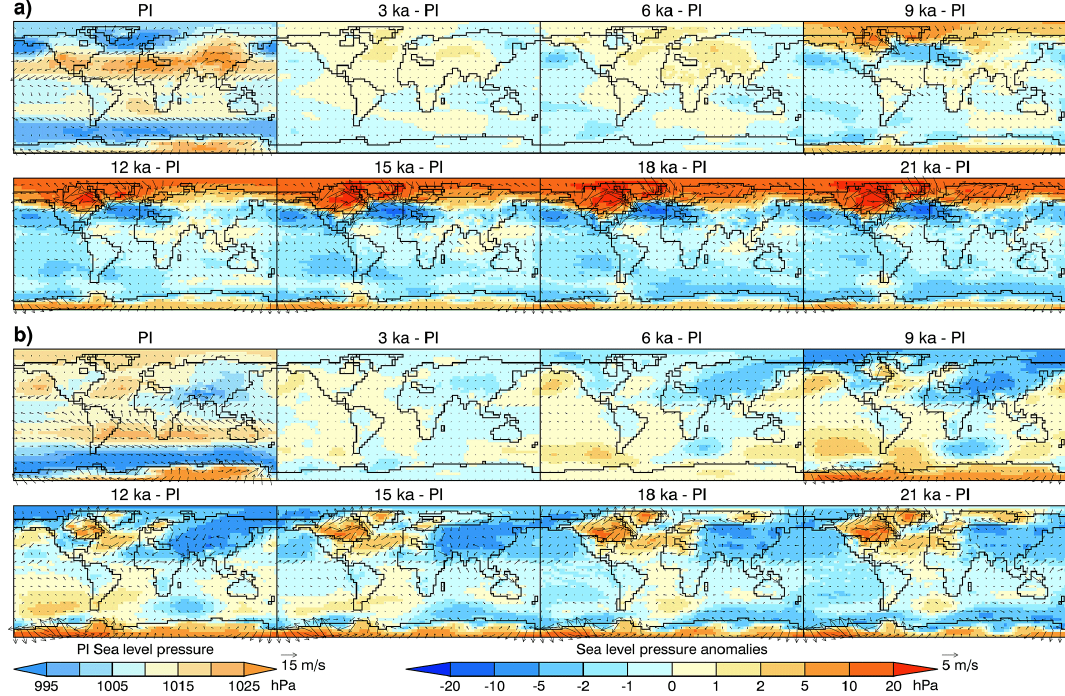
Figure 4. Simulated seasonal average sea level pressure and 2m wind anomalies relative to PI. (a) December, January, and February and (b ) June, July, and August. Raw sea level pressure and wind are shown in Fig. S3.